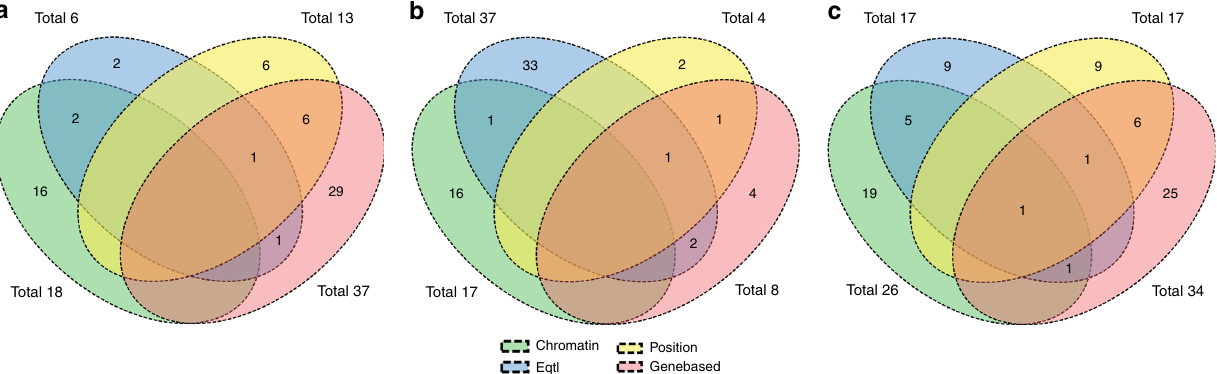
Fig. 4 Number of overlapping genes between gene mapping methods. Number of overlapping genes between FUMA eQTL mapping, FUMA chromatin interaction mapping, ANNOVAR chromosome positional mapping, and MAGMA gene-based analysis for all cortical regions combined for cortical surface area ( a ), thickness ( b ) and volume ( c ).